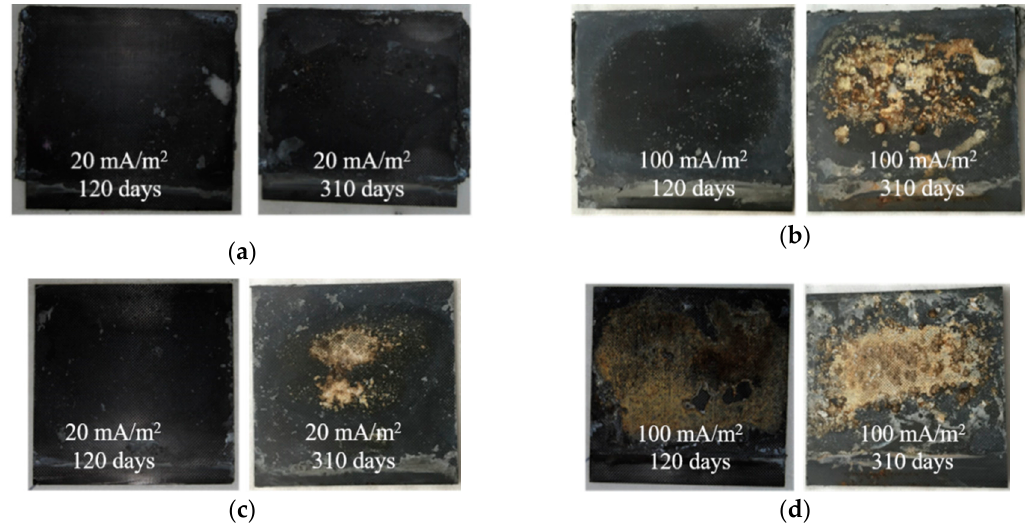
Figure 9. Degradation of the EB and IB CFRP: ( a ) B-EB-20 specimens; ( b ) B-EB-100 specimens; ( c ) B-IB-20 specimens; ( d ) B-IB-100 specimens.